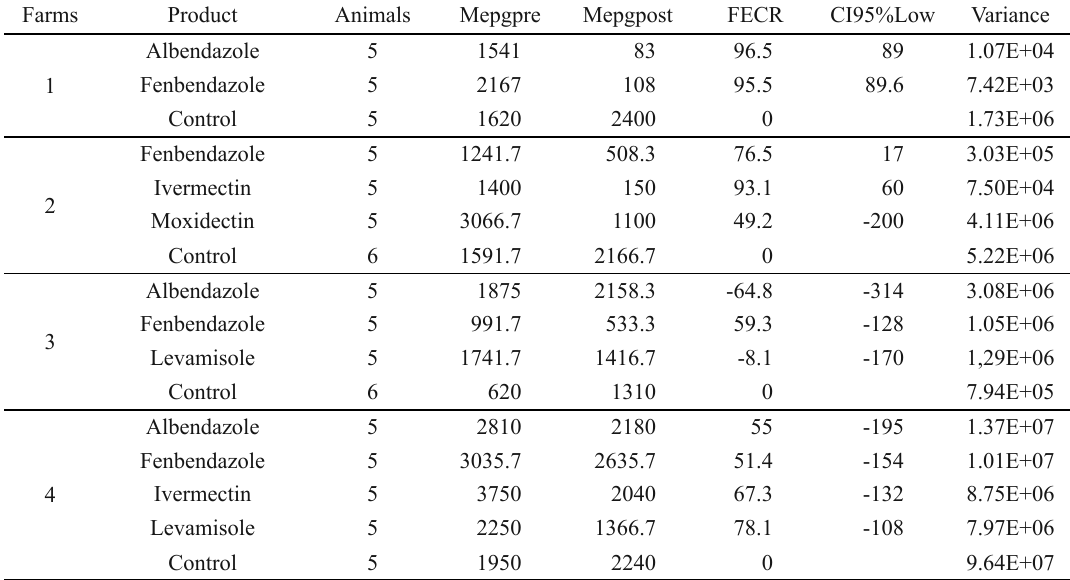
Mean of eggs per gram in pretreatment (Mepgpre) and post-treatment (Mepgpos), percentage of faecal egg count reduction (FECR), and lower 95% con fi dence interval (CI95%Low) after anthelmintic treatments in sheep in